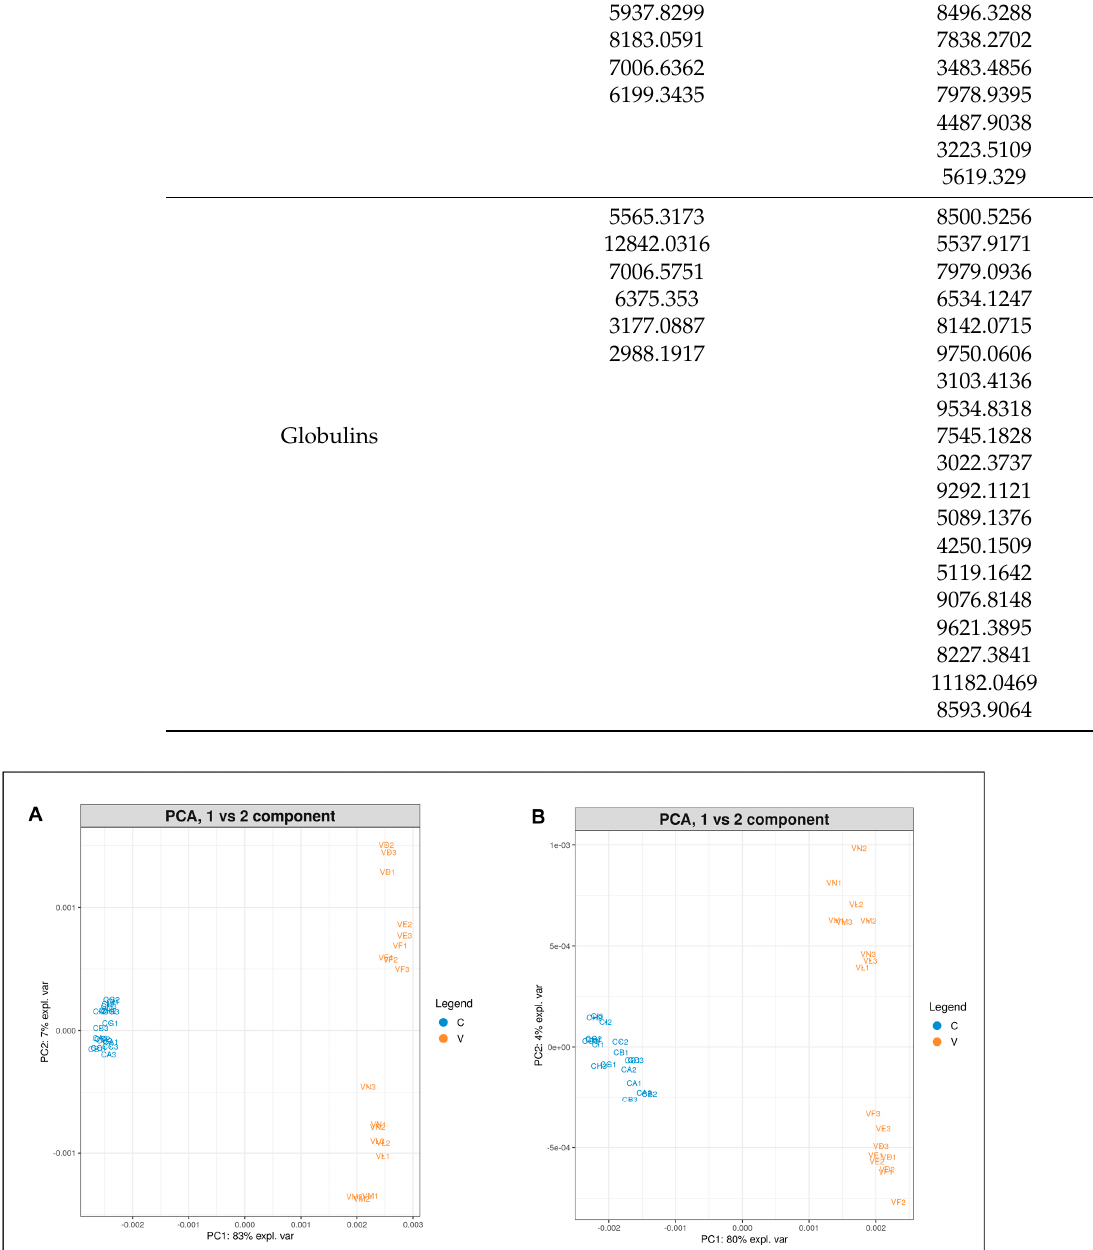
Figure 7. PCA plot (PC1 vs. PC2) of albumin ( A ) and globulin ( B ) extracts from Secuieni J. certified seeds (C, blue) and harvested seeds from the experimental field of Viganella (V, orange).